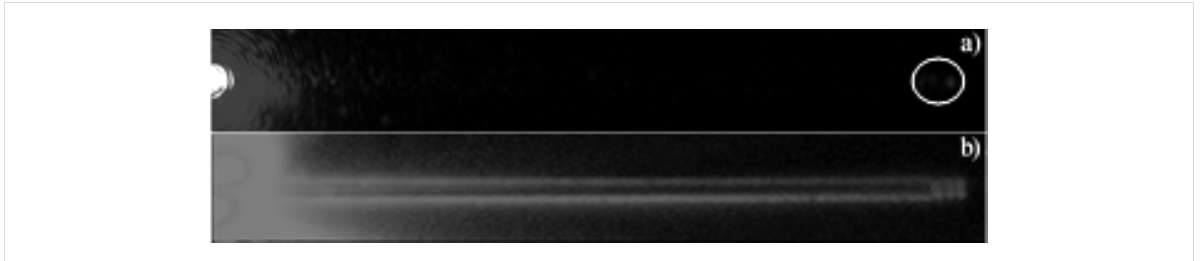
Figure 6: 20 µm stripes a) plasmon outcoupling when excited via grating coupling, b) QD coupling. Spacer layer 20 nm.